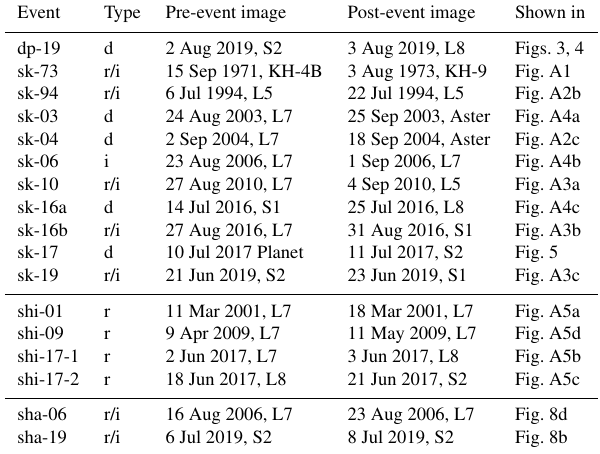
Table 4. Satellite imagery that limit the date of occurrence of the events. Dates are given according to ISO-8601. Event types abbre- viations are described in Sect. 3.1. Referred figures show images with the best visibility of the events; they can differ from the im- ages that limit the date of